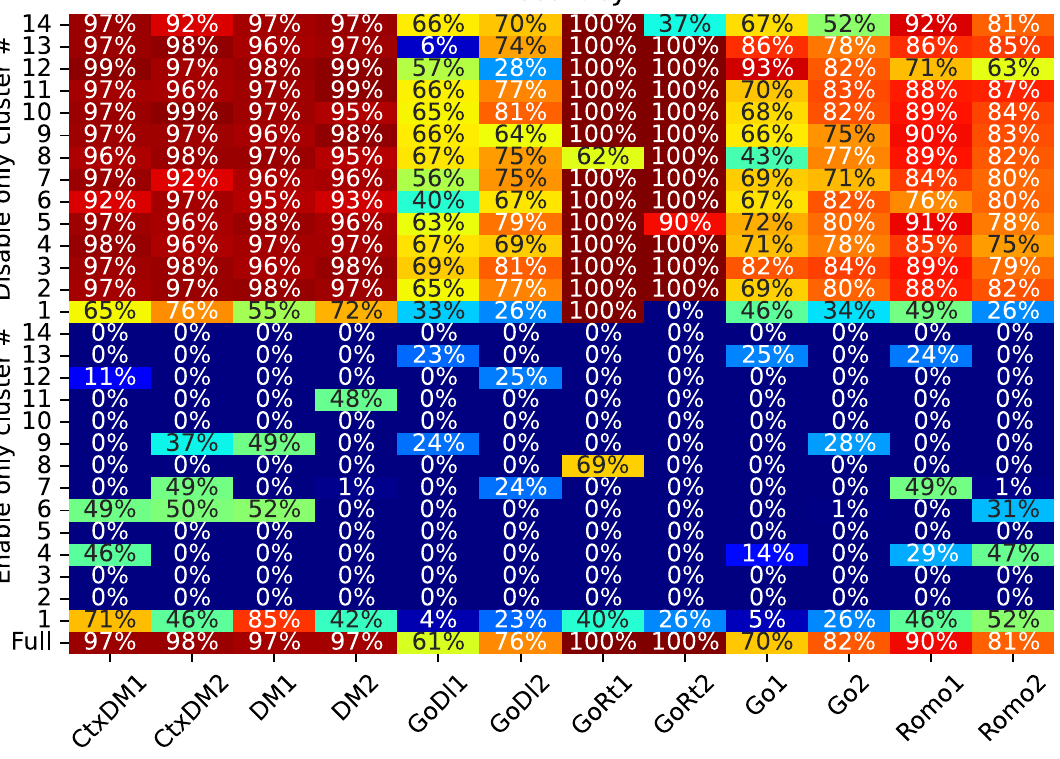
Figure 12. Network performance for different tasks is shown below the table when particular clusters, denoted on the left-hand side, are lesioned (top part) or switched on (bottom part). The last row indicates the mean- squared error of the original network performance for particular target tasks. Each data point is obtained for the network with 256 neurons trained with the regularized loss function after averaging over 200 test